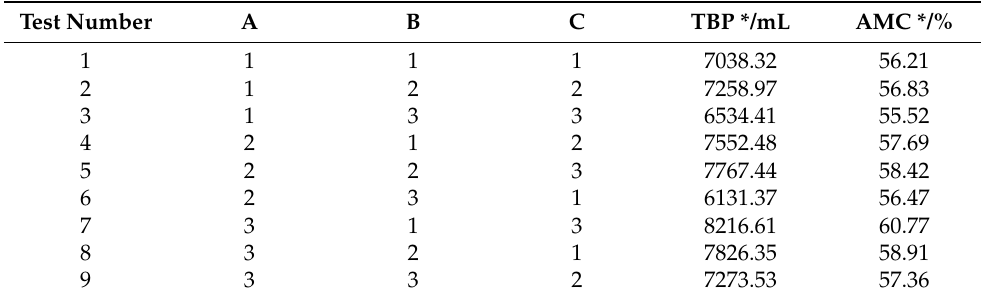
Table 4. Total biogas production and average methane concentration in biogas residue from pig manure anaerobic digestion.